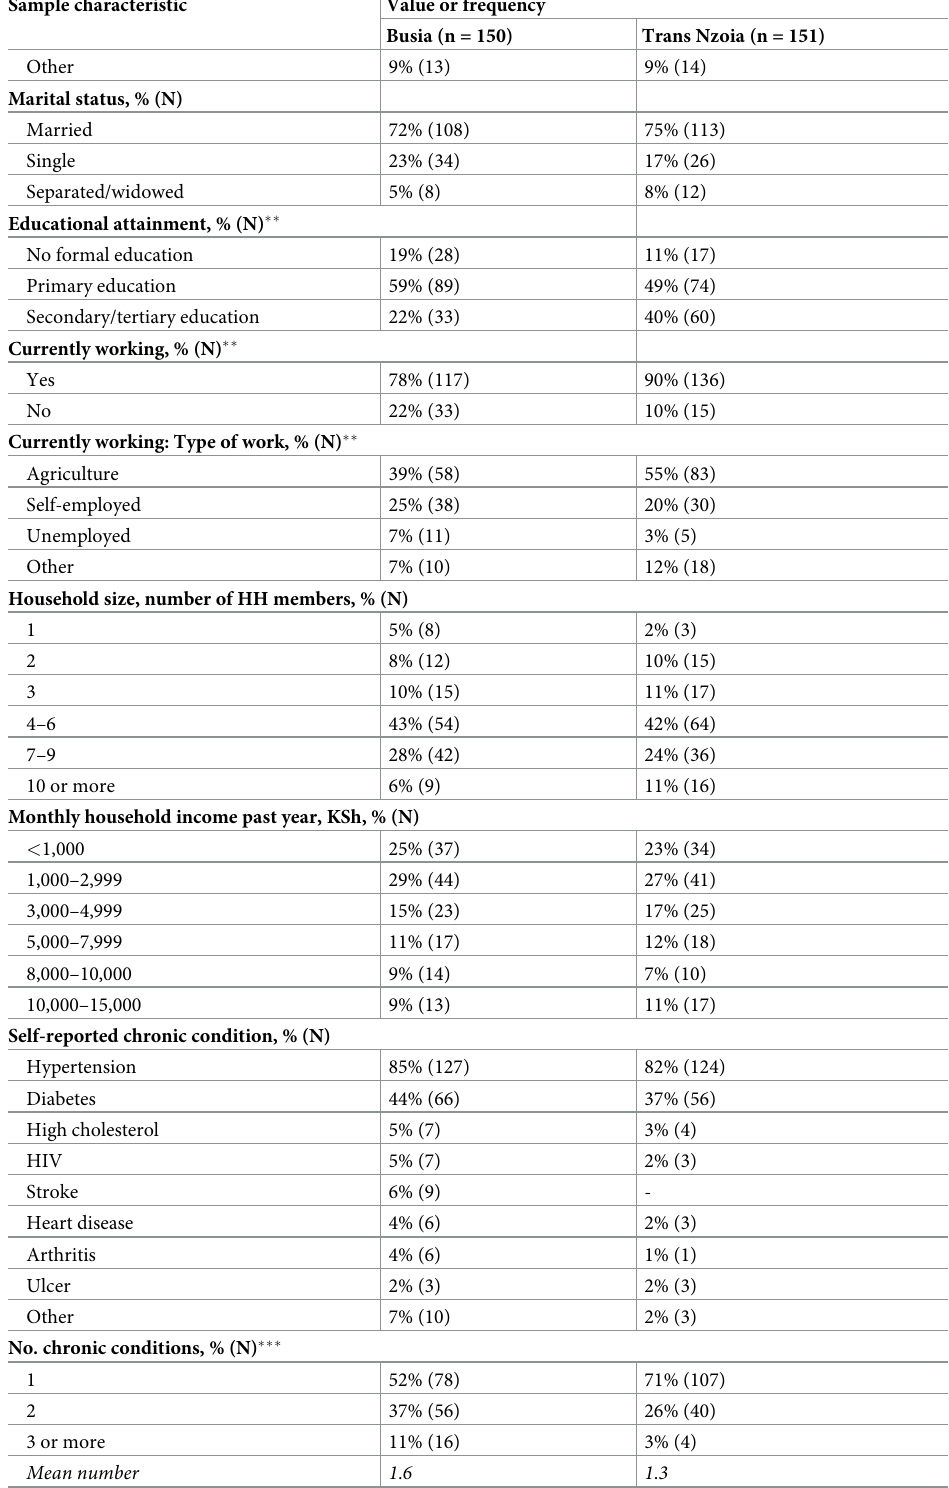
Table 1. Socio-demographic and health-related characteristics of the patient sample by